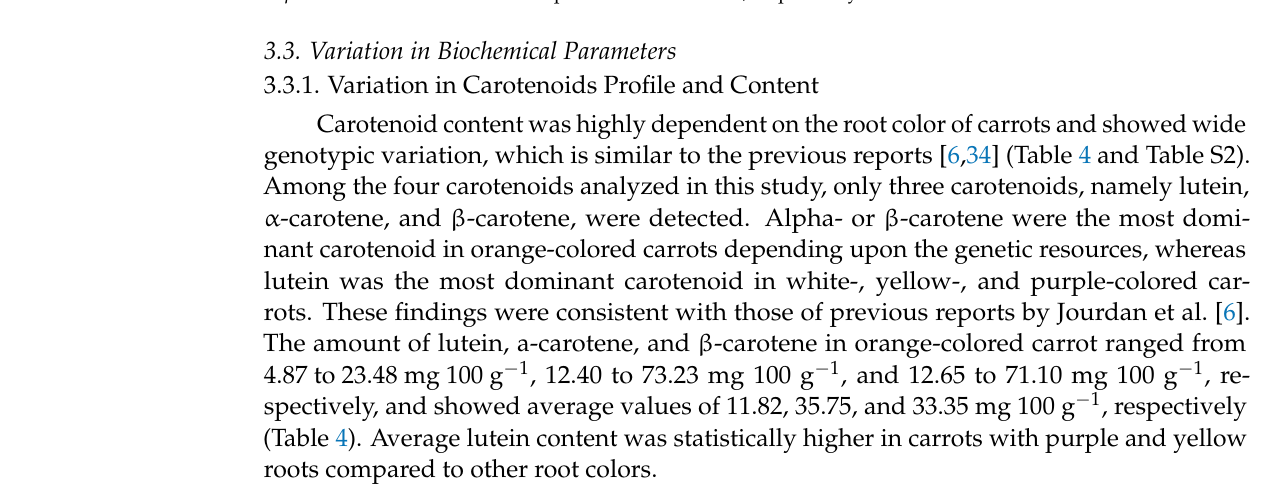
Table 4. Variation in carotenoids in carrot genetic resources ( n =